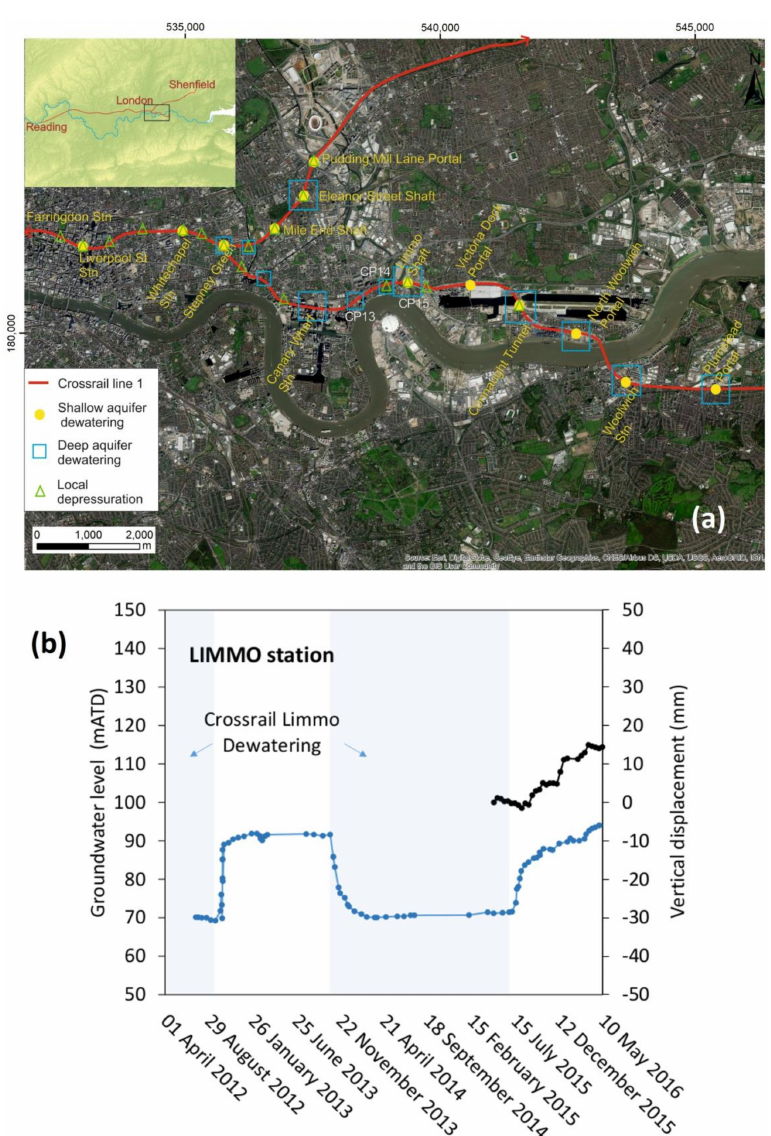
Figure 12. ( a ) Location of the Crossrail line 1 and the dewatering sites. ( b ) Cross-comparison of the average TS obtained using the Sentinel-1 data in a buffer zone of 50 m from Limmo shaft and the groundwater level changes measured at Limmo station. Dewatering periods are also